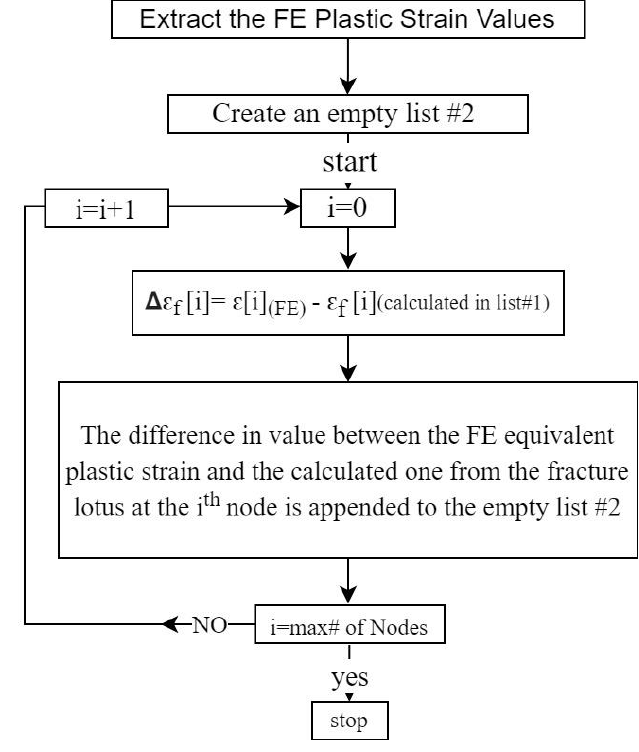
Figure A1. Flow chart describing the method in which the theoretical plastic strain at fracture of each node is calculated.